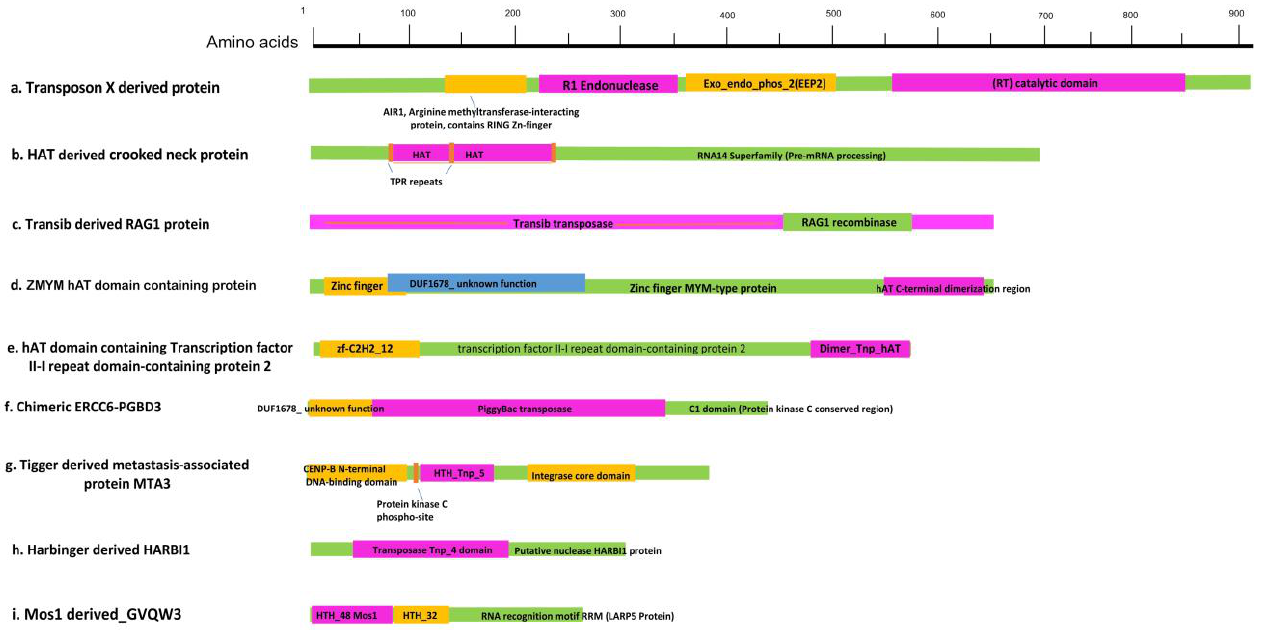
Figure 4. Transposon-derived protein sequences (domesticated) in the genome of S. chinensis . Amino acid sequences analysis of the eight (a–i) transposon-derived proteins retrieved representing at least one transposon domain domesticated in them. The sequence regions colored pink and orange in the sequences are mainly derived from TEs. The scale at the top represents the number and position of amino acids in the proteins.